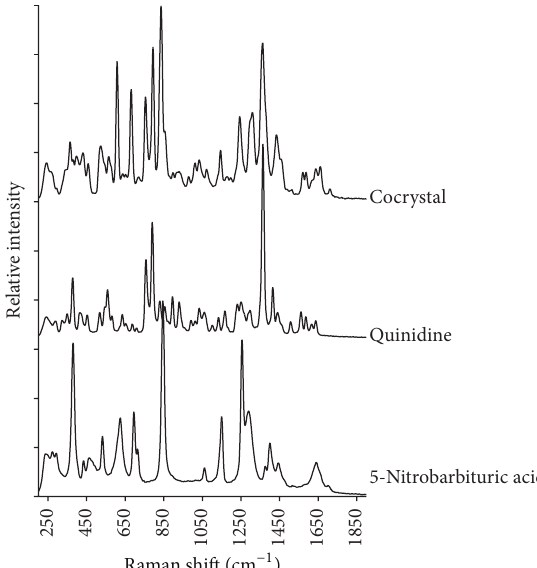
Figure 13: Infrared absorption spectra within the fingerprint region of 5-nitrobarbituric acid, quinidine, and the 1:1 nitrobarbituric- quinidine cocrystal.